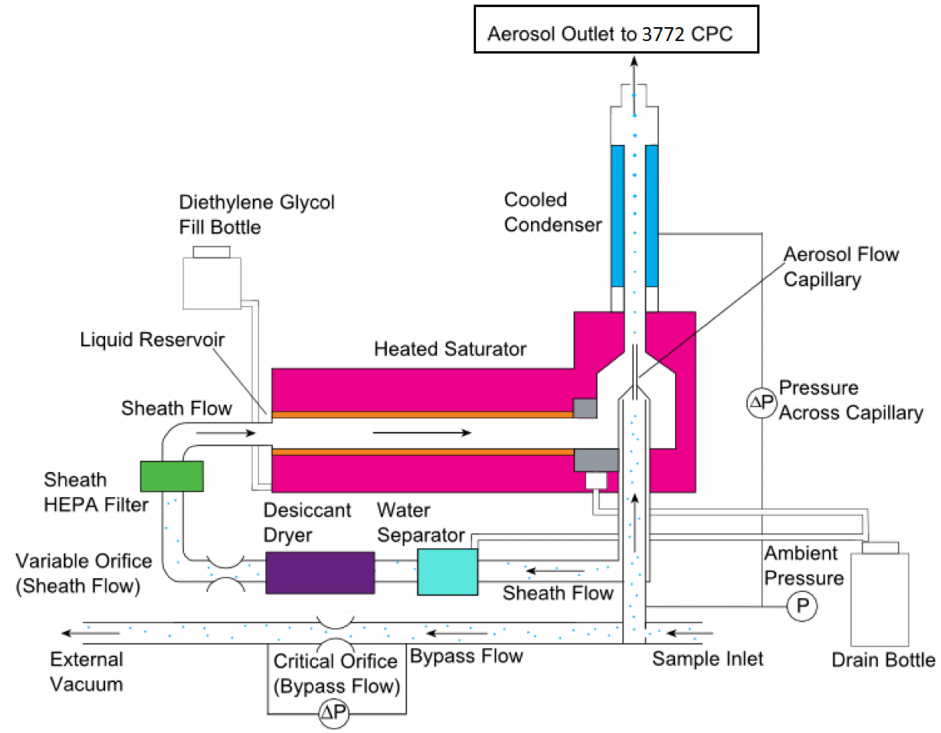
Figure 1. TSI 3777 nano enhancer (courtesy of TSI